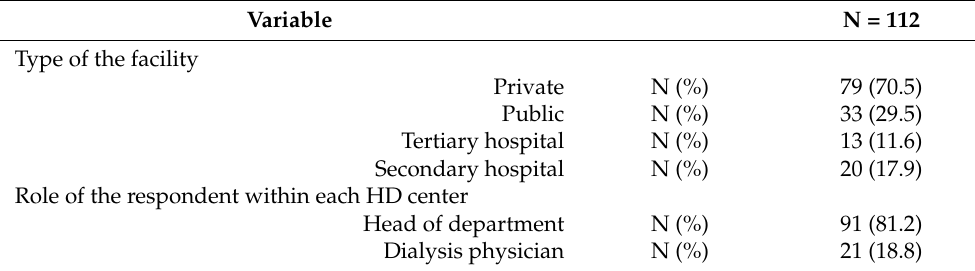
Table 1. Participants